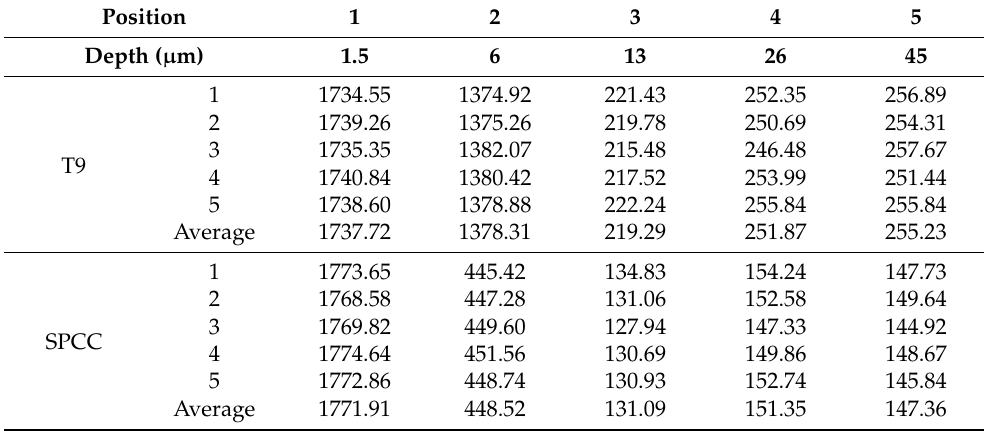
Figure 7. ( a ) Schematic diagram of the indentation of chromized T9 steel; ( b ) load–press-depth curves of chromized T9 steel; ( c ) schematic diagram of indentation of chromized SPCC steel; ( d ) load–press-depth curves of chromized SPCC steel. Table 2. Micro-Vickers hardness (HV) of the chromized T9 and SPCC steels at different depths from the surface.